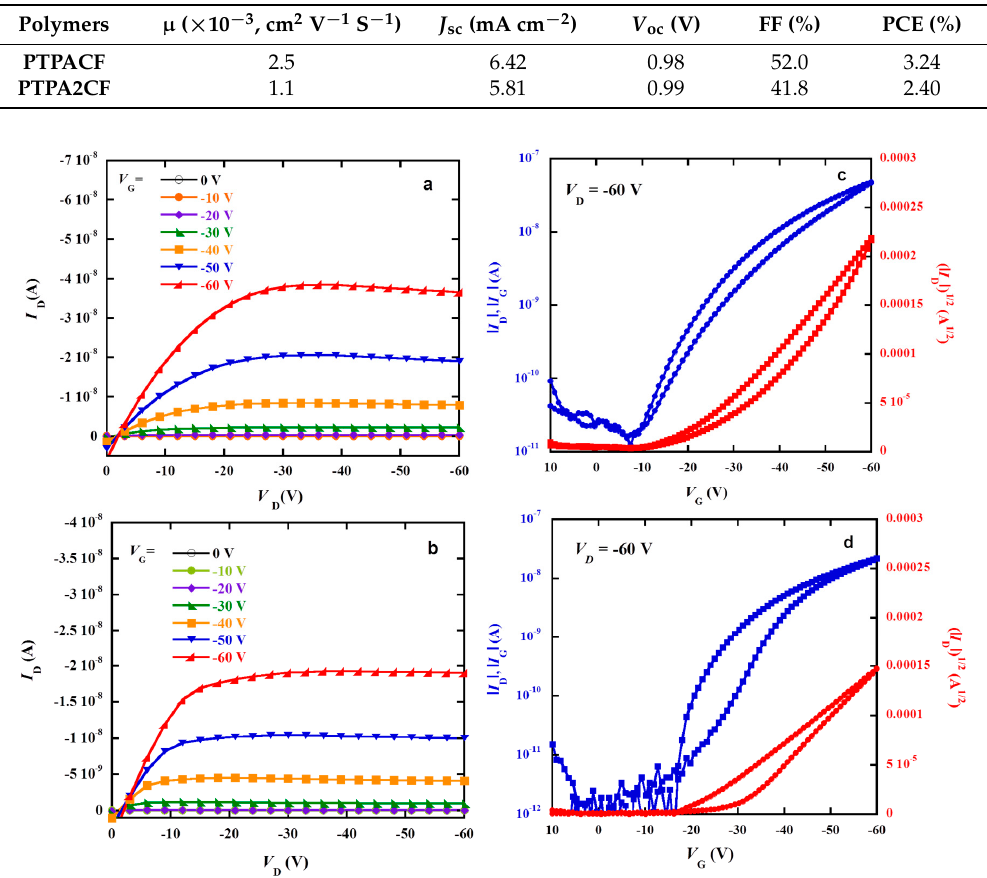
Table 3. Summarized photovoltaic performance of the PTPACF:PC 71 BM and PTPA2CF:PC 71 BM based PSCs under the illumination of AM1.5G, 100 mW cm − 2 .